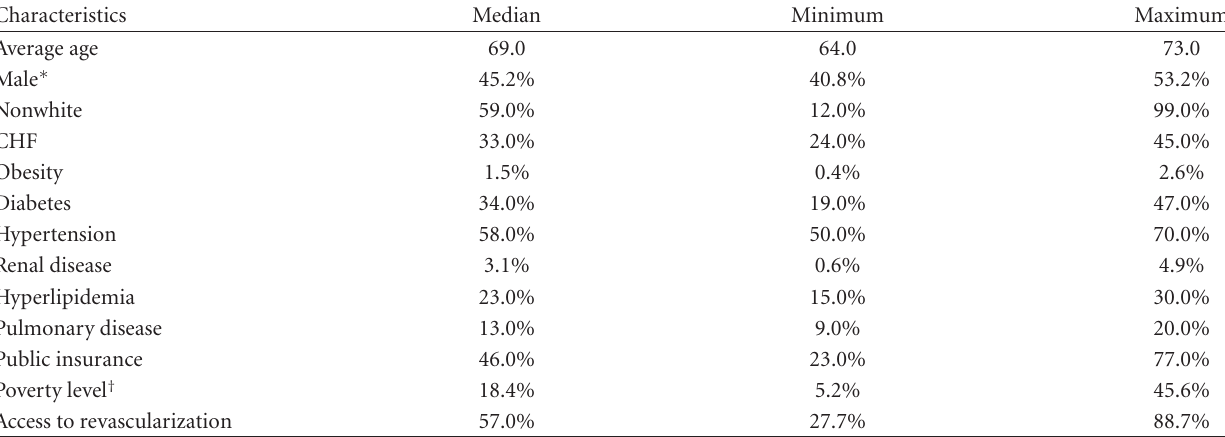
Table 1: Descriptive summary of patient characteristics and comorbidity in NYC neighborhoods, 1998–2002.